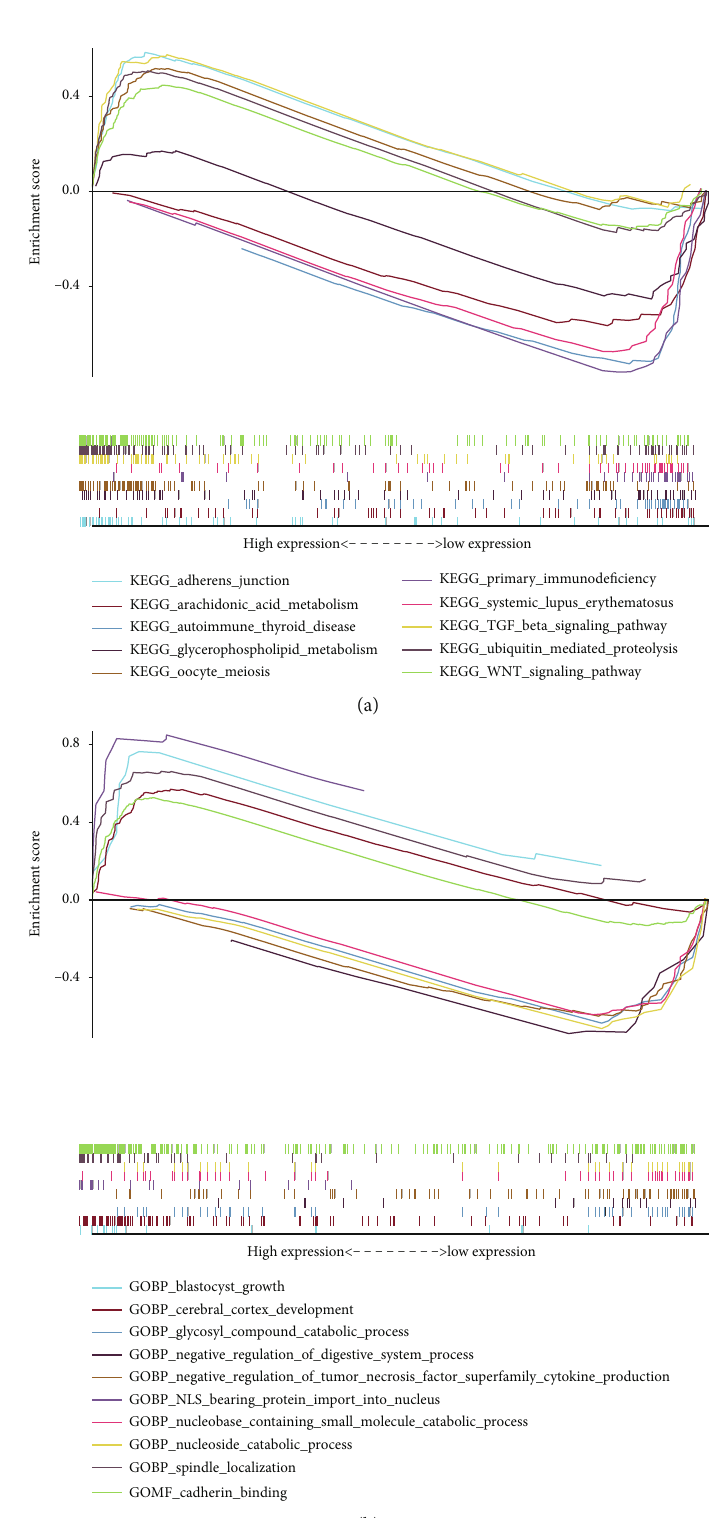
Figure 3: GSEA of the dysregulated genes between low-risk and high-risk groups. (a) GSEA results of di ff erential enrichment of KEGG genes and lncRNA expression associated with necroptosis. (b) GSEA data of di ff erential enrichment of GO and lncRNA expressions associated with